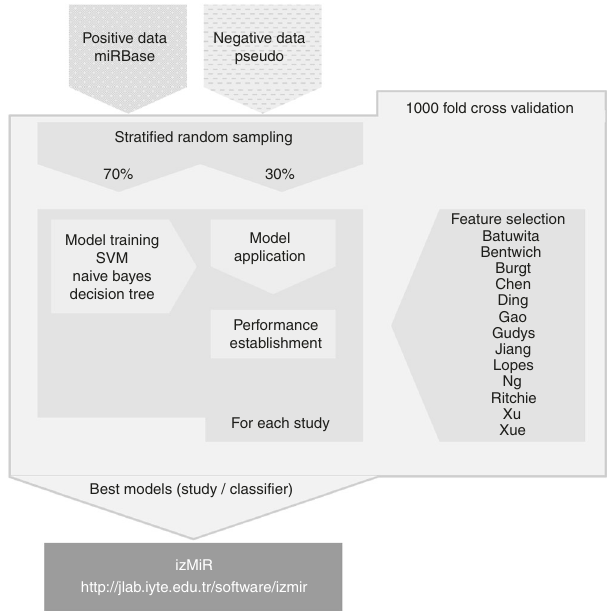
Fig. 3 Model training work fl ow. Filtered human miRNA hairpins from miRBase served as positive data and pseudo hairpins for negative